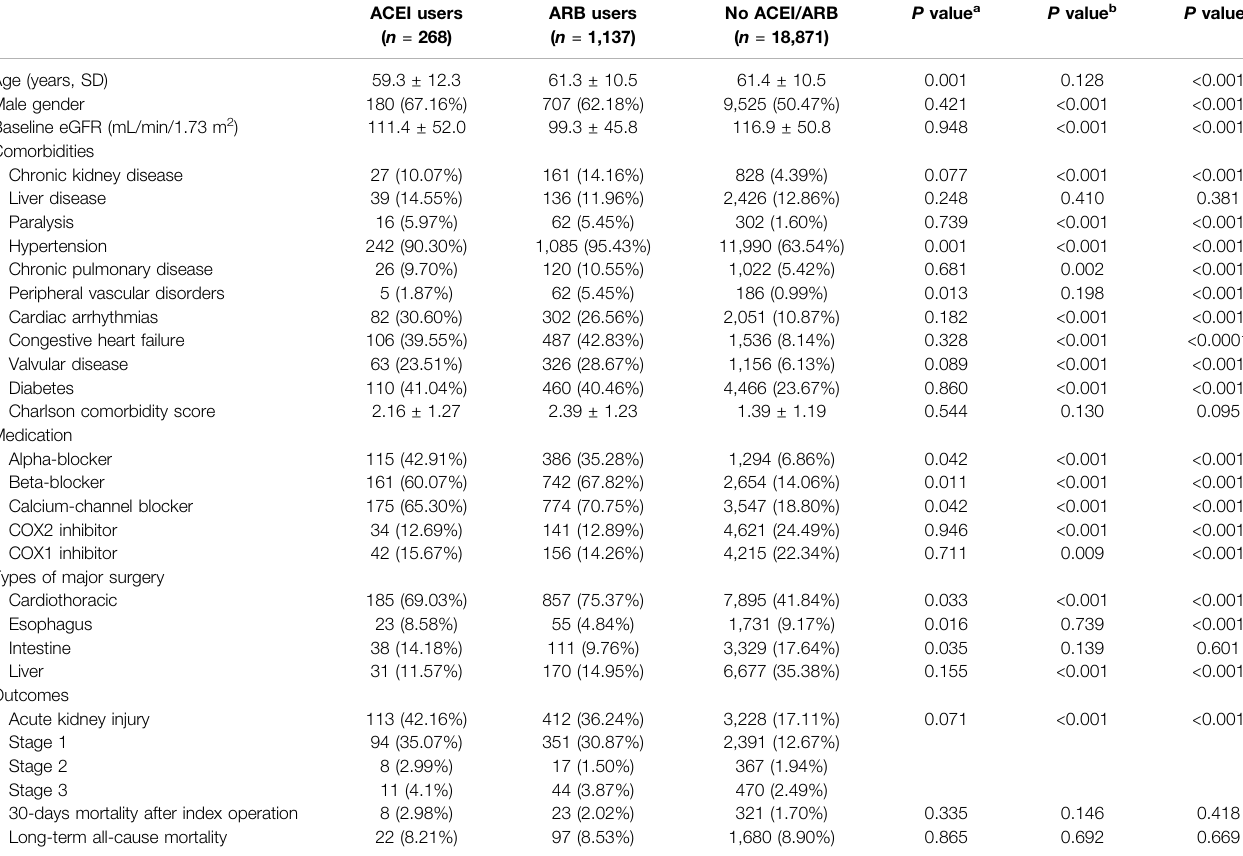
TABLE 1 | Demographic data, comorbidities, medications, and surgery types of the three groups classi fi ed by exposure to angiotensin-converting-enzyme inhibitors or angiotensin receptor